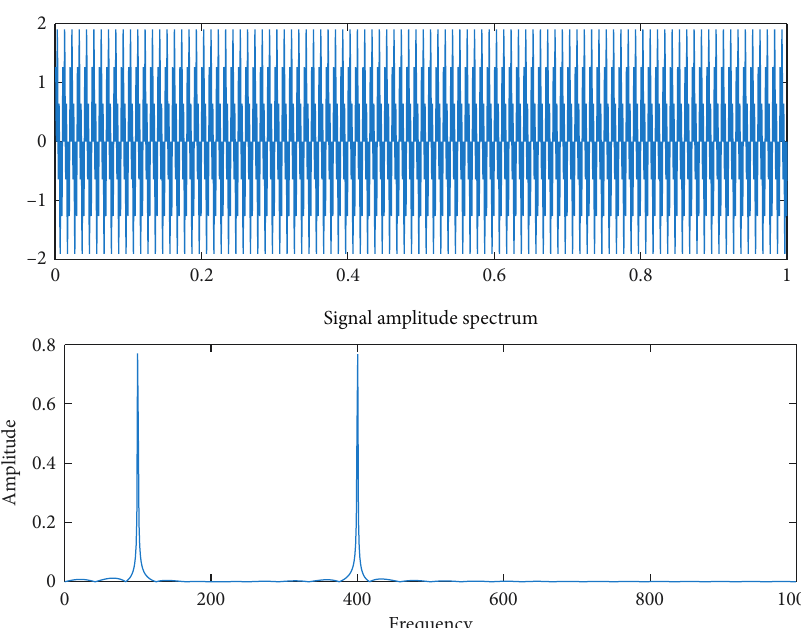
Figure 7: Amplitude frequency response of image sequence signal after filtering.